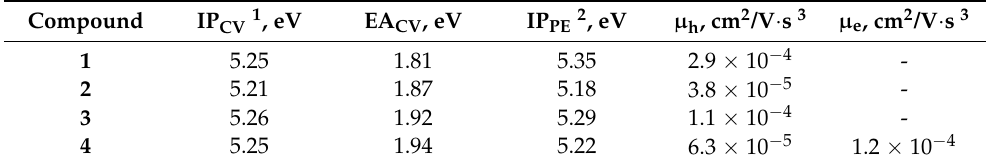
Table 2. Electrochemical and photoelectrical characteristics of compounds 1 – 4 .